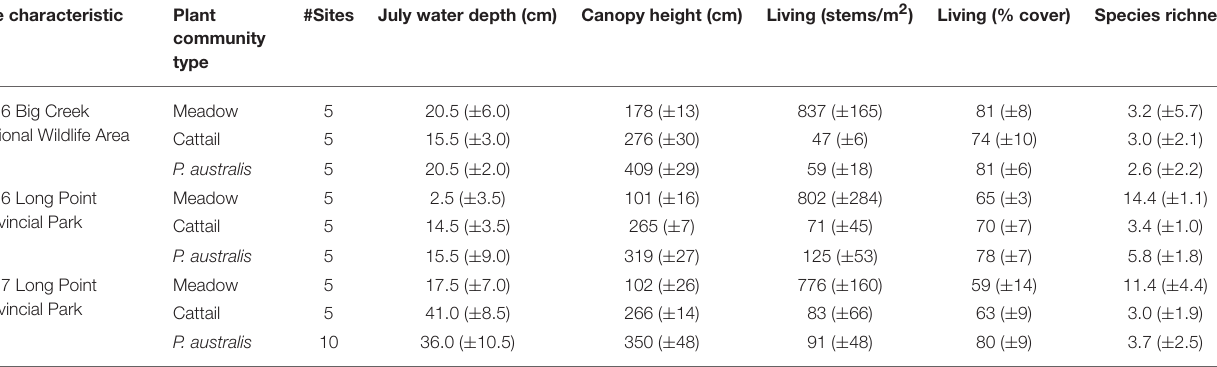
TABLE 1 | Average site characteristics of meadow, cattail, and P. australis -invaded marsh, based on measurements from three quadrats per site. Site